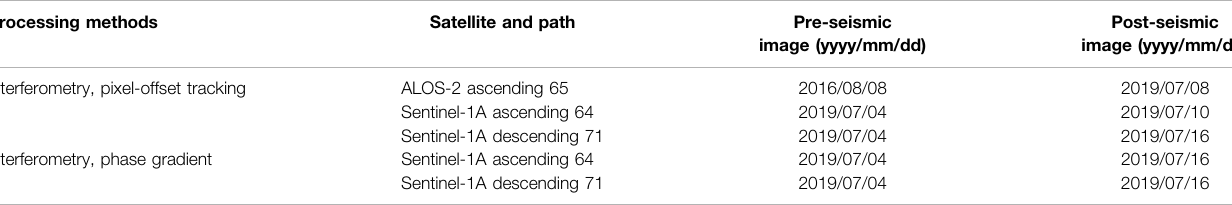
TABLE 1 | Multi-source SAR images and handling methods.